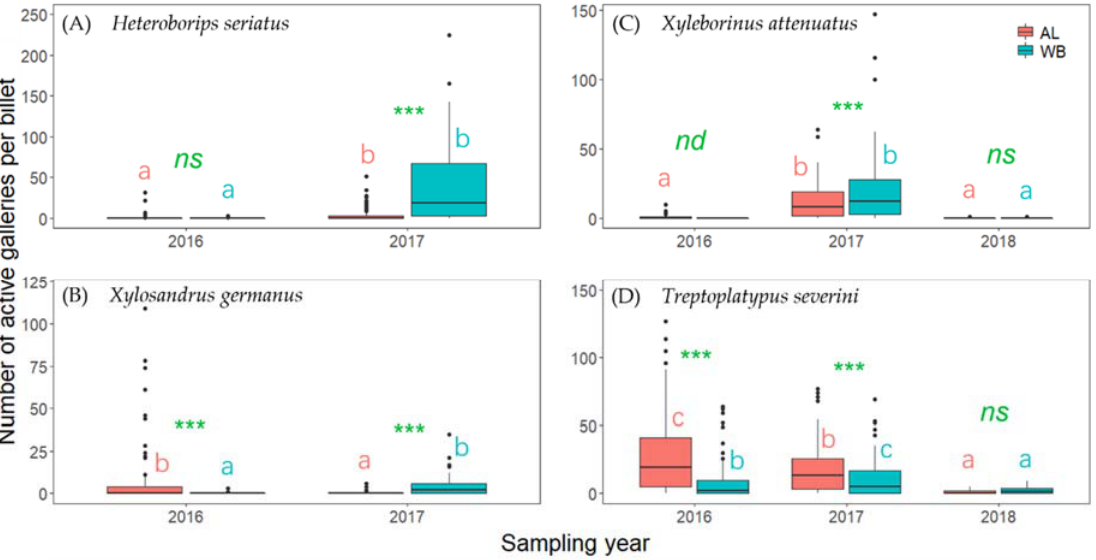
Figure 3. The number of active holes per billet of the four most abundant species found in alder (AL) and white birch (WB) logs in different sampling years (( A ) Heteroborips seriatus , ( B ) Xylosandrus germanus , ( C ) Xyleborinus attenuatus , and ( D ) Treptoplatypus severini ). Data for H. seriatus and X. germanus in 2018 are not shown, as no individuals were found in that year. The effects of the tree species and sampling year on the number of active galleries were tested using ZIP models. Different lowercase letters indicate that the number of active galleries for the same tree species differed significantly between the sampling years. *** indicate a significant difference in the number of active galleries between AL and WB in the same sampling year at the 0.001 level. ns indicates no significant differences in the number of active galleries between tree species in the same sampling year. nd indicates significance could not be determined as no X. attenuatus was sampled from WB logs in 2016.